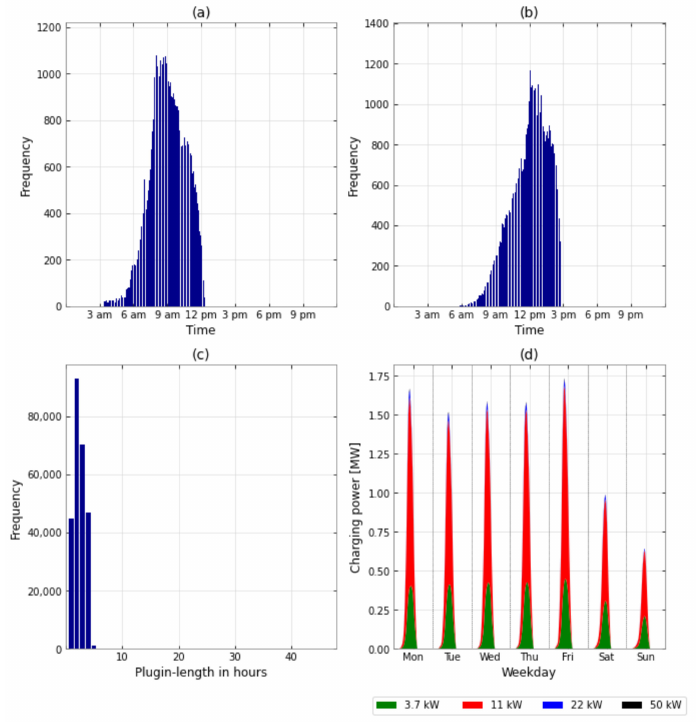
Figure A9. Charging characteristics of temporal charging cluster 7: ( a ) Frequency of different plug-in times; ( b ) Frequency of different plug-out times; ( c ) Frequency of different plug-in lengths; ( d ) Charging power used.